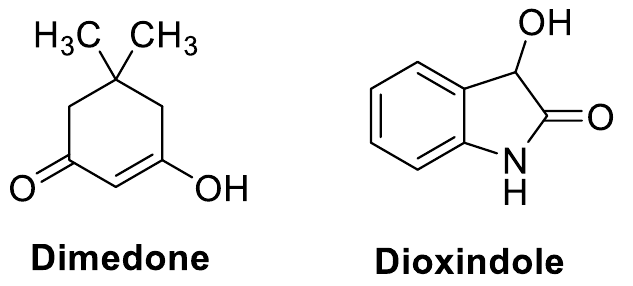
Figure 2. Separate fragments constituting the anionic part of compound 4 .